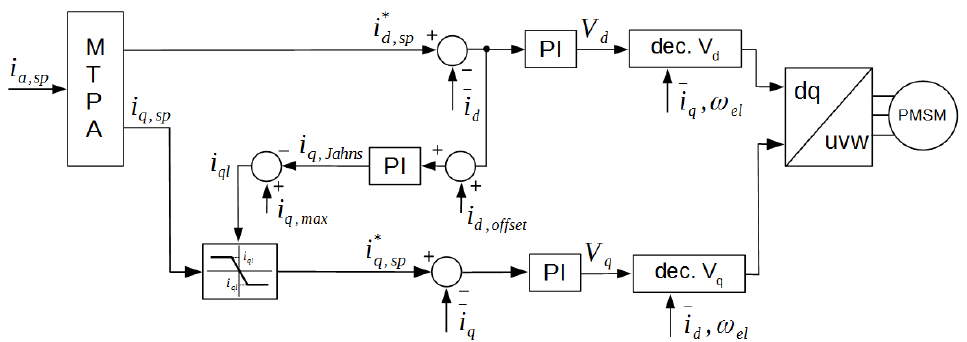
Figure 4. Traditional control scheme proposed in [16] based on i sd current error.